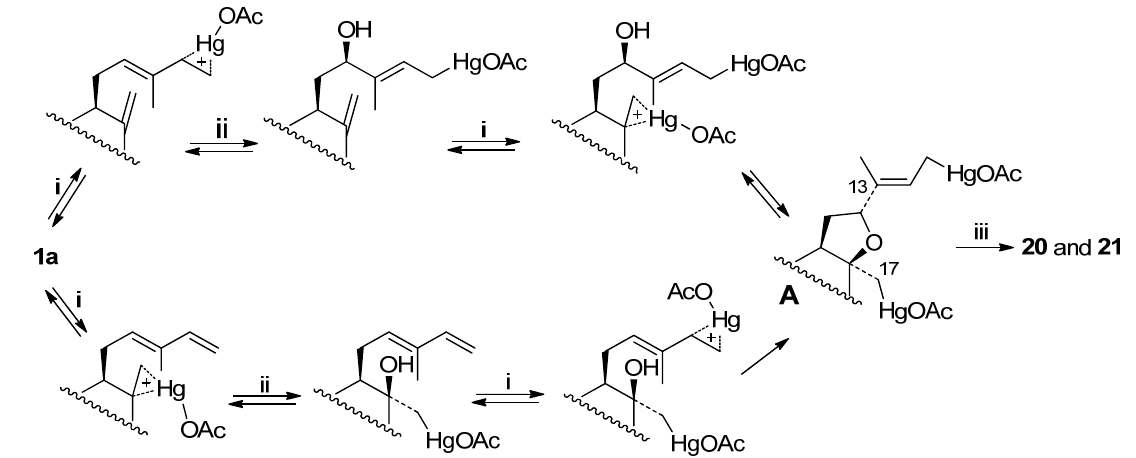
Scheme 2. Mechanism of formation of compounds 20 , 21